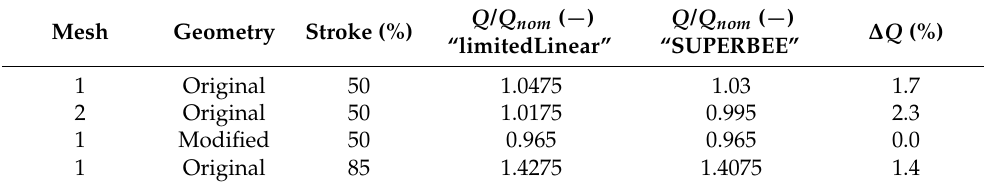
Table 3. Discharge predicted by the simulation depending on the limiter